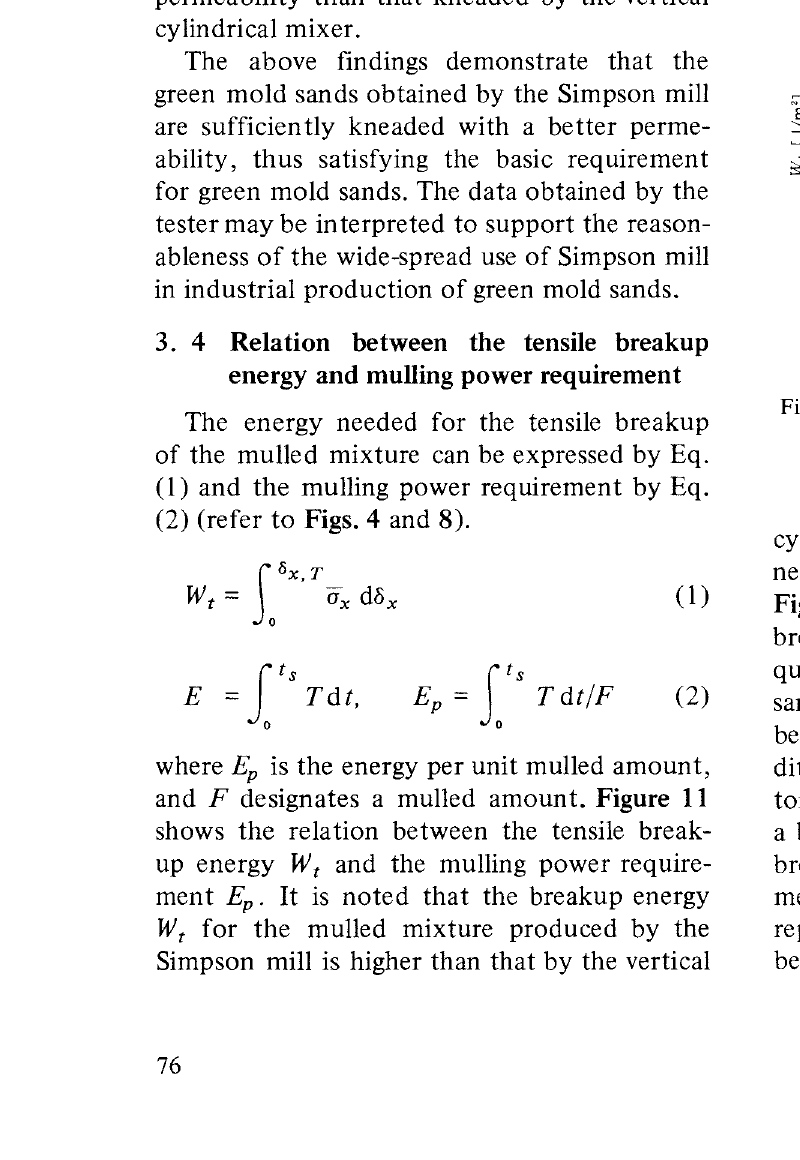
Fig. 1 0 Compression characteristics of mulled mixture